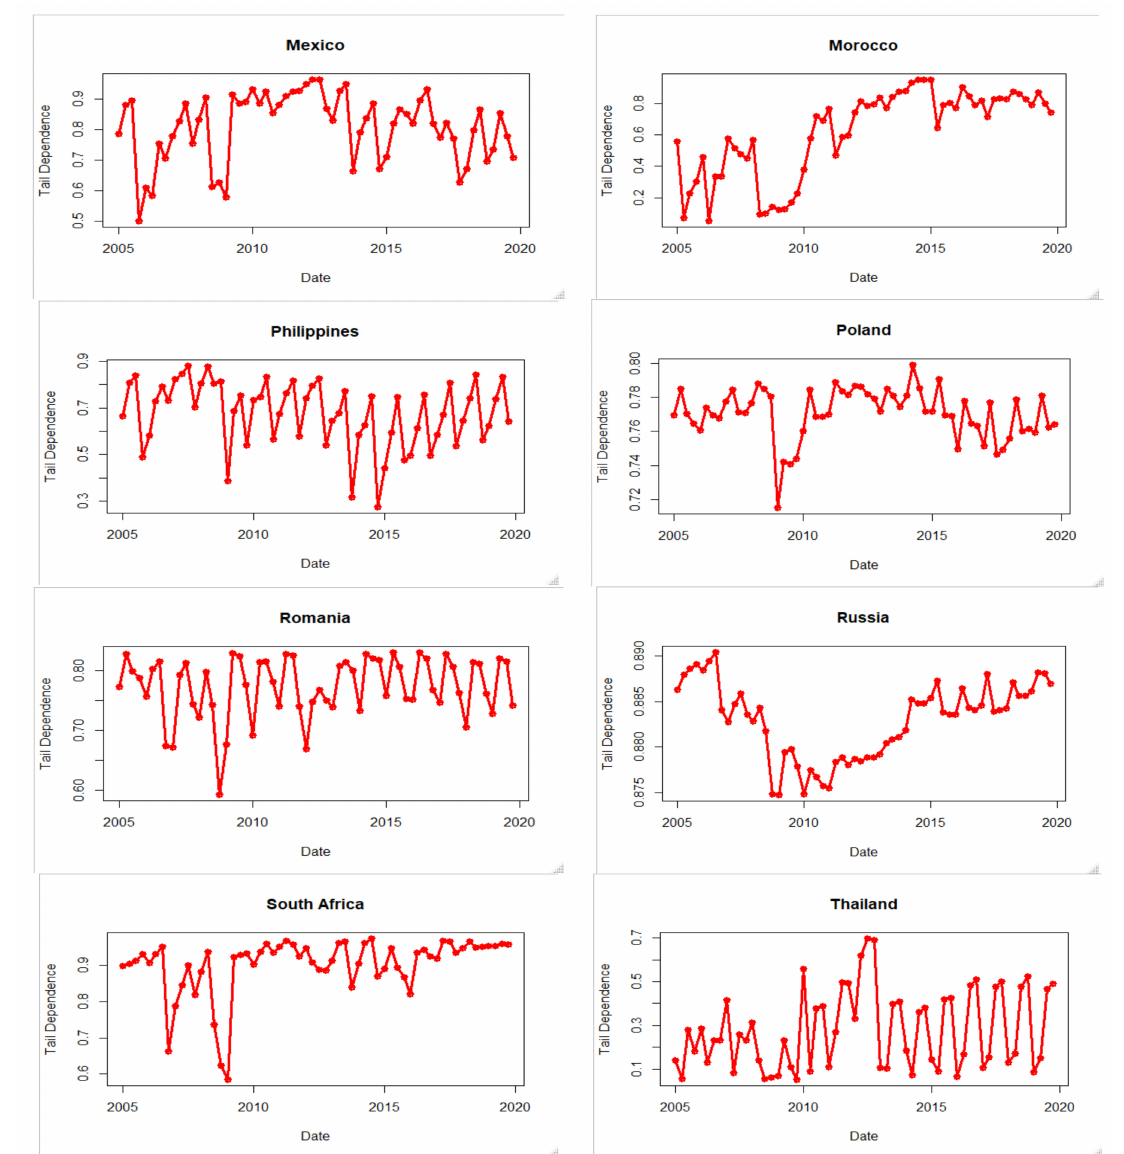
Figure 2. Time-varying tail dependence (contagion risk) between the U.S. economy and emerging countries: Mexico, Morocco, the Philippines, Poland, Romania, Russia, South Africa, and